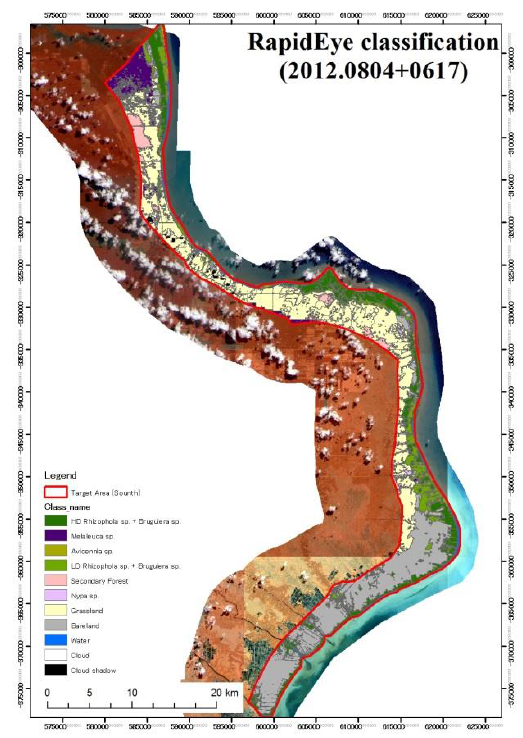
Figure 4. The result of classification of types of tree species